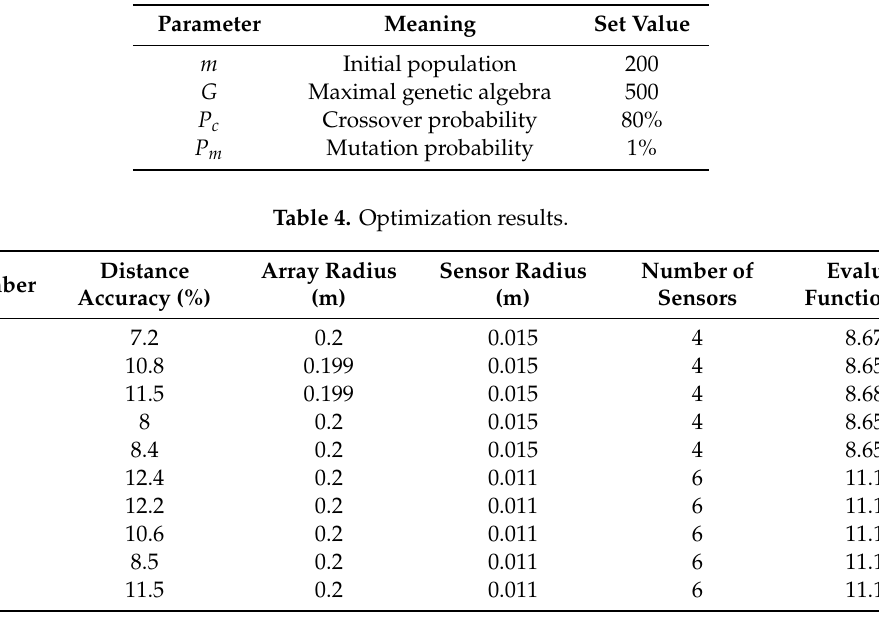
Table 3. Genetic algorithm parameter settings.